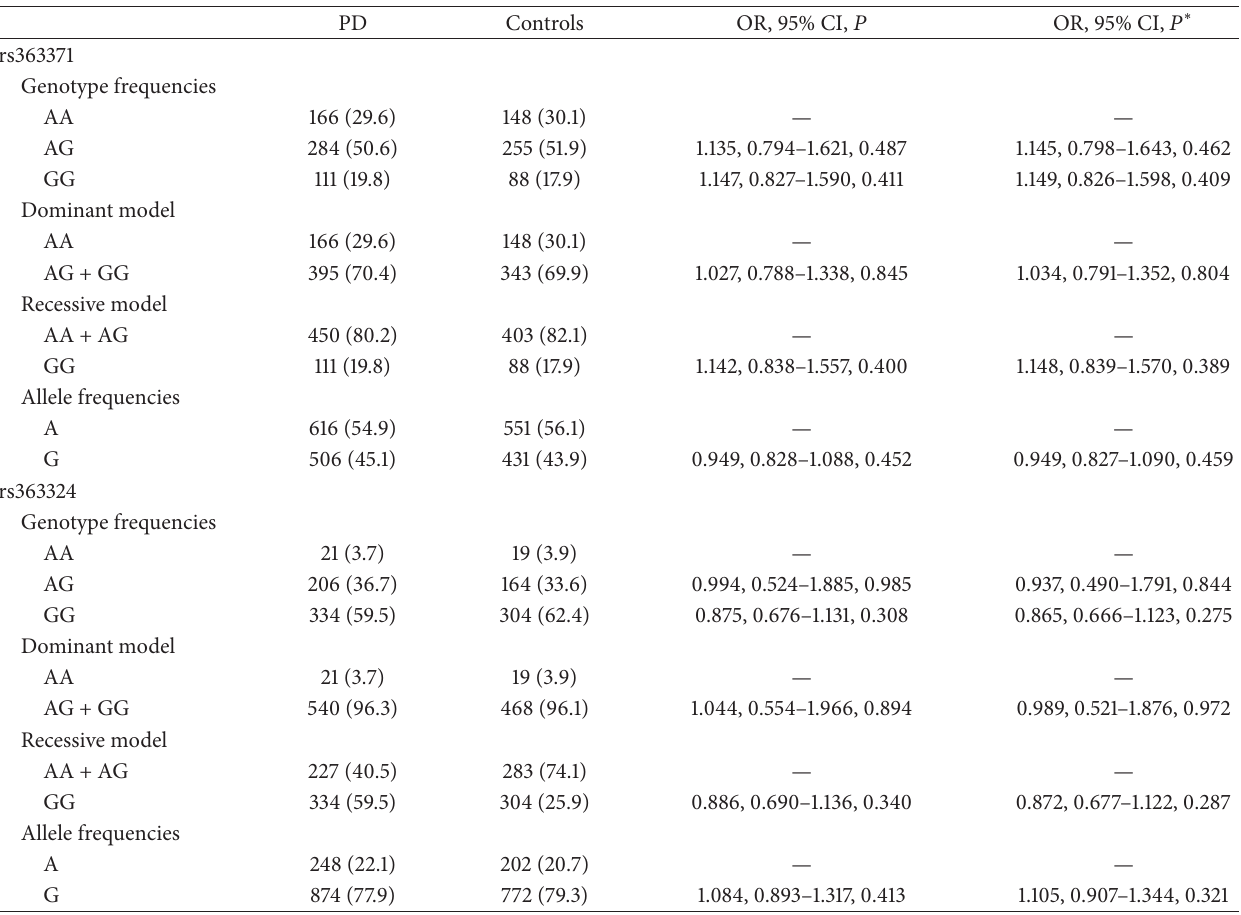
Table 2: Distribution of genotypes and alleles at rs363371 and rs363324 among Han Chinese with Parkinson’s disease (PD) and healthy